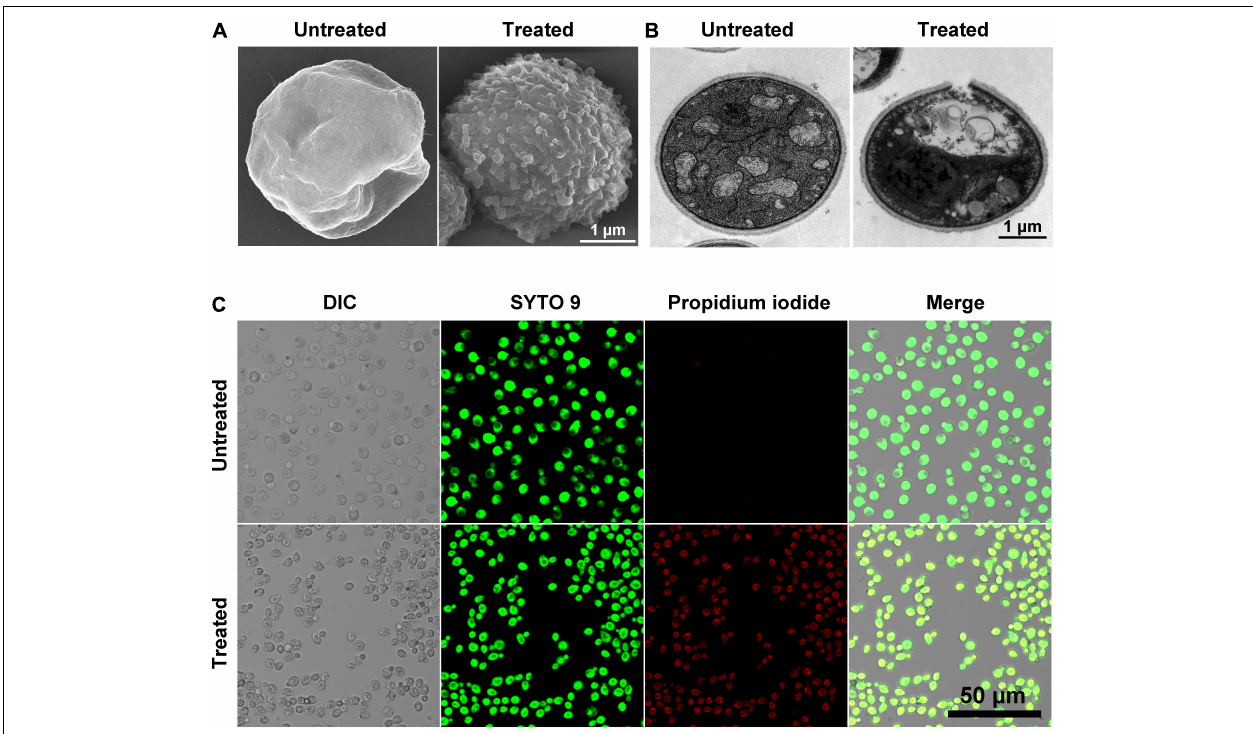
FIGURE 6 | Scanning electron microscope (SEM), transmission electron microscope (TEM) and confocal laser scanning microscopy (CLSM) images show the effect of Sparamosin 26 - 54 on C. neoformans . (A,B) The morphology of C. neoformans treated with Sparamosin 26 - 54 observed by SEM and TEM. (C) Live-dead staining assay shows the differentially stained cells after Sparamosin 26 - 54